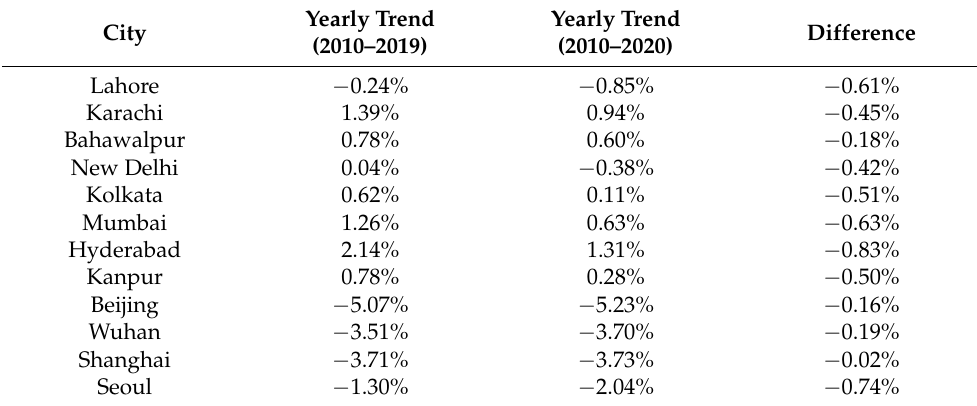
Table 3. Percentage NO 2 increase or decrease per year from 2010 to 2019, and from 2010 to 2020, as well as the differences for the 12 locations.